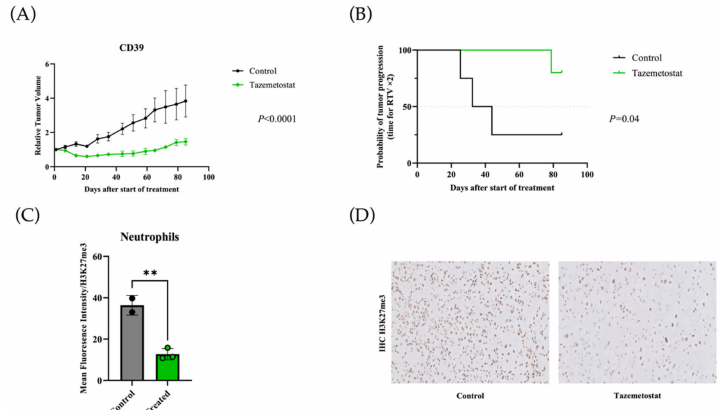
Figure 4. In vivo efficacy of tazemetostat in the CD39 chordoma PDX and pharmacodynamics study. PDX tumor-bearing mice were randomized into each treatment group ( n = 5 per group) and treated with tazemetostat 75 mg/kg twice a day, 5 days per week (green). Untreated control is shown in black. ( A ) Relative tumor volume. Tumor growth was evaluated by plotting the mean of the relative tumor volume ± SD per group. ( B ) Probability of tumor progression. The time to reach RTV x 2 for each treated mouse was calculated. ( C ) Results for the FACS analysis in neutrophils. A clear shift of the H3K27me3 staining in the treated group compared to the control was observed (** achieve statistical significance compared to control ( p = 0.005) by Mann–Whitney test). ( D ) Immunohistochemical (IHC) staining results for H3K27me3 in treated mice with anti-EZH2 drug (tazemetostat) and control mice. A decreased expression of H3K27me3 was noted in the treatment group in comparison with the control group (magnification ×